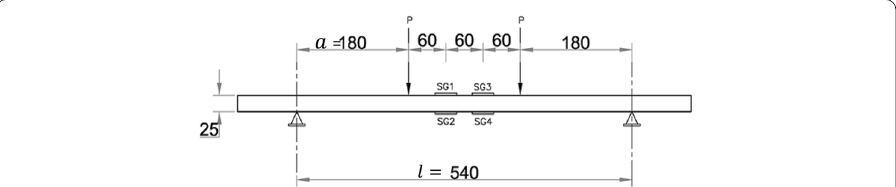
Fig. 5 Beam bending test for rigidity of pile and calibration of strain gauges (all dimensions are in